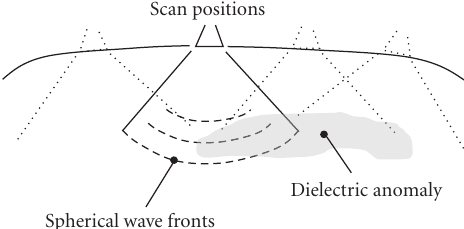
Figure 7: Microimpulse radar signal propagation in the body.